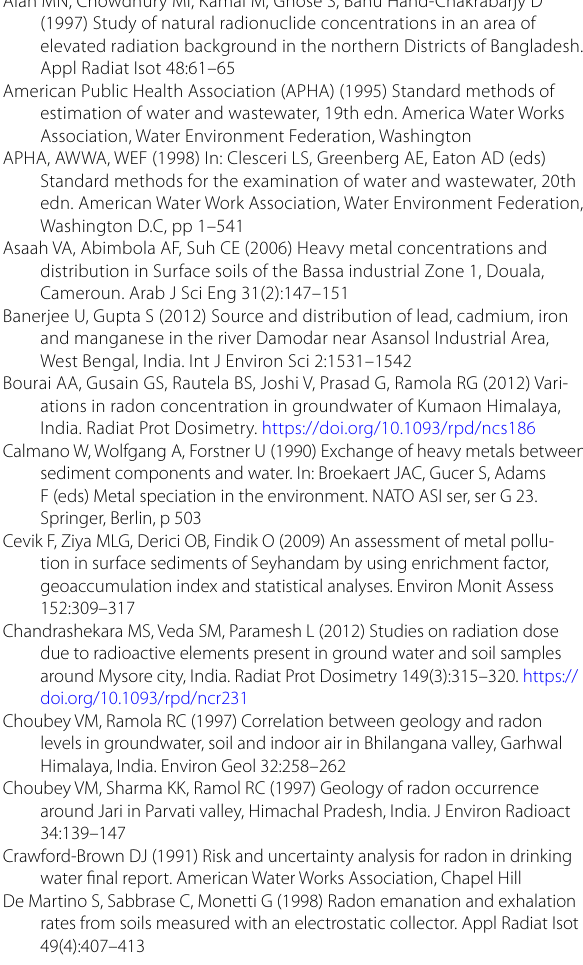
Additional file 1: Figure S1. The readings obtained from countings. Figure S2. Typical alpha energy spectrum